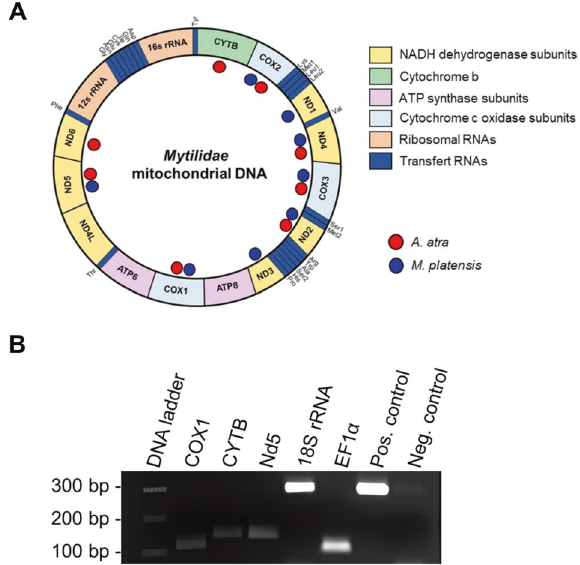
Fig. 3 Validation of DNA fragments of self-origin. A Presence of different mitochondrial genes in the hemolymph of A. atra (red points – Accession: SRX5705969) and M. platensis (blue points – Accession: SRX5705968) ampli fi ed by PCR. Figure was adapted from Breton et al ., 2011 B Ampli fi cations of hemolymph supernatant from A. atra stored on FTA papers. PCR ampli fi cations of HKG 18S rRNA, Elongation factor 1 α (EF1 α ) and mitochondrial genes Cytochrome b (CYTB), Cytochrome c oxidase subunit 1 (COX1), and NADH dehydrogenase subunit 5 (Nd5) were carried out with a 3 mm punch directly added into the PCR tube containing the PCR